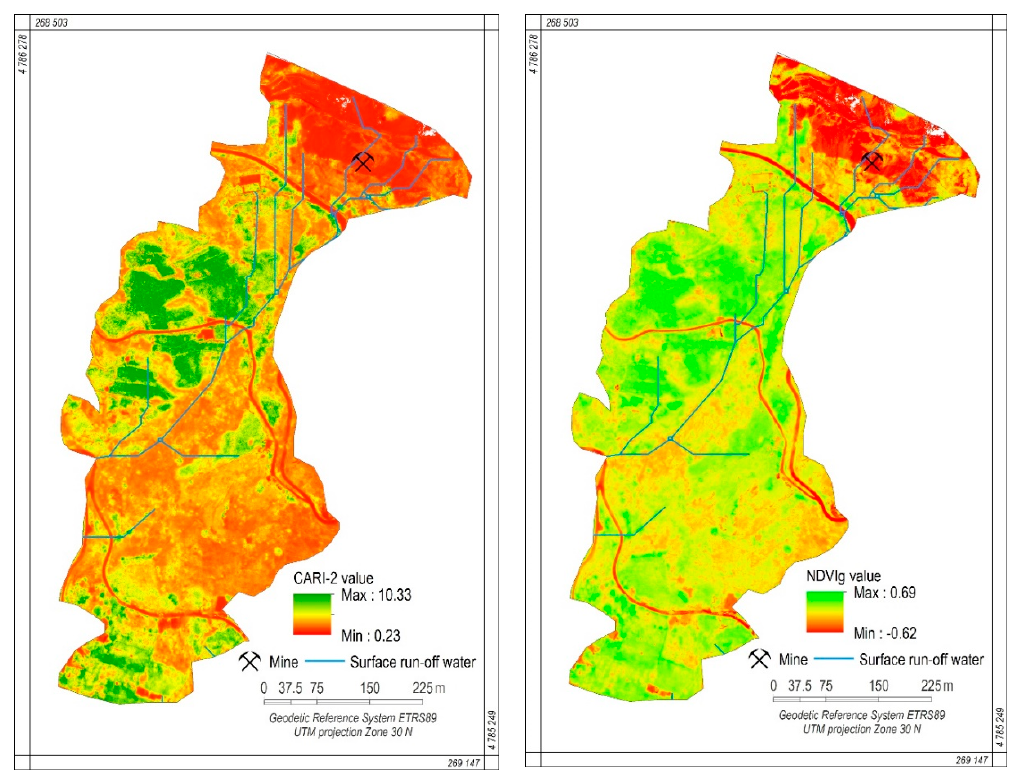
Figure 4. Results of the vegetation indices Left: CARI2; good correlation with As and Right: NDVIg; good correlation with Hg.